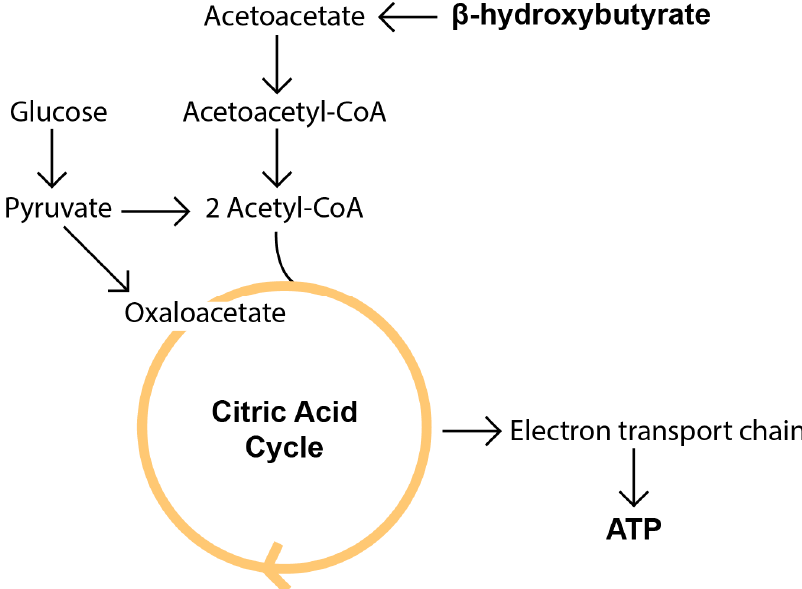
Figure 2. The basic metabolism of beta hydroxybutyrate compared to glucose. KBs arise from liver fatty acid metabolism occurring primarily in the hepatic mitochondrial matrix. Then, they are captured from circulation by extrahepatic tissues and used as an energy source. β HB is oxidized by β HB dehydrogenase to produce AcAc, which takes up CoA from succinyl-CoA to produce acetoacetyl-CoA. Acetoacetyl-CoA then reacts with CoA to produce two molecules of acetyl-CoA, a key intermediate for the citric acid cycle (reviewed in [16,37,43]).